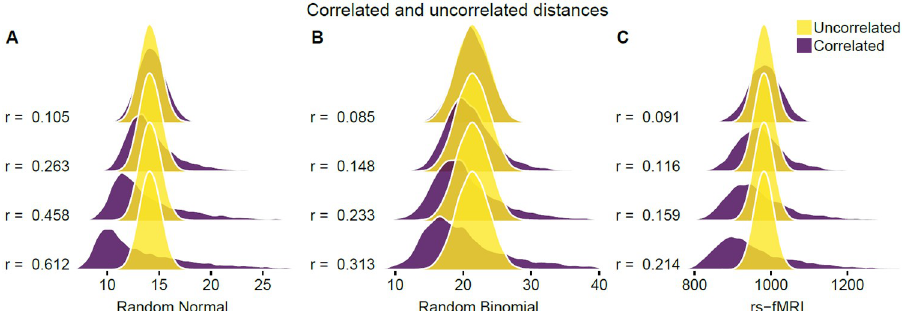
Fig 12. Distance densities from uncorrelated vs correlated bioinformatics data. ( A ) Euclidean distance densities for random normal data with and without correlation. Correlated data was created by multiplying random normal data by upper-triangular Cholesky factor from randomly generated correlation matrix. We created correlated data for average absolute pairwise correlation (Eq 176) � r ¼ 0 : 105 ; 0 : 263 ; 0 : 458 ; and 0 : 612 . ( B ) TiTv distance densities for random abs binomial data with and without correlation. Correlated data was created by first generating correlated standard normal data using the Cholesky method from (A). Then we applied the standard normal CDF to create correlated uniformly distributed data, which was then transformed by the inverse binomial CDF with n = 2 trials and success probabilites for all a 2 A . ( C ) Time series correlation-based distance densities for random rs-fMRI data (Fig 9) with and f a without additional pairwise feature correlation. Correlation was added to the transformed rs-fMRI data matrix (Fig 9) using the Cholesky algorithm from